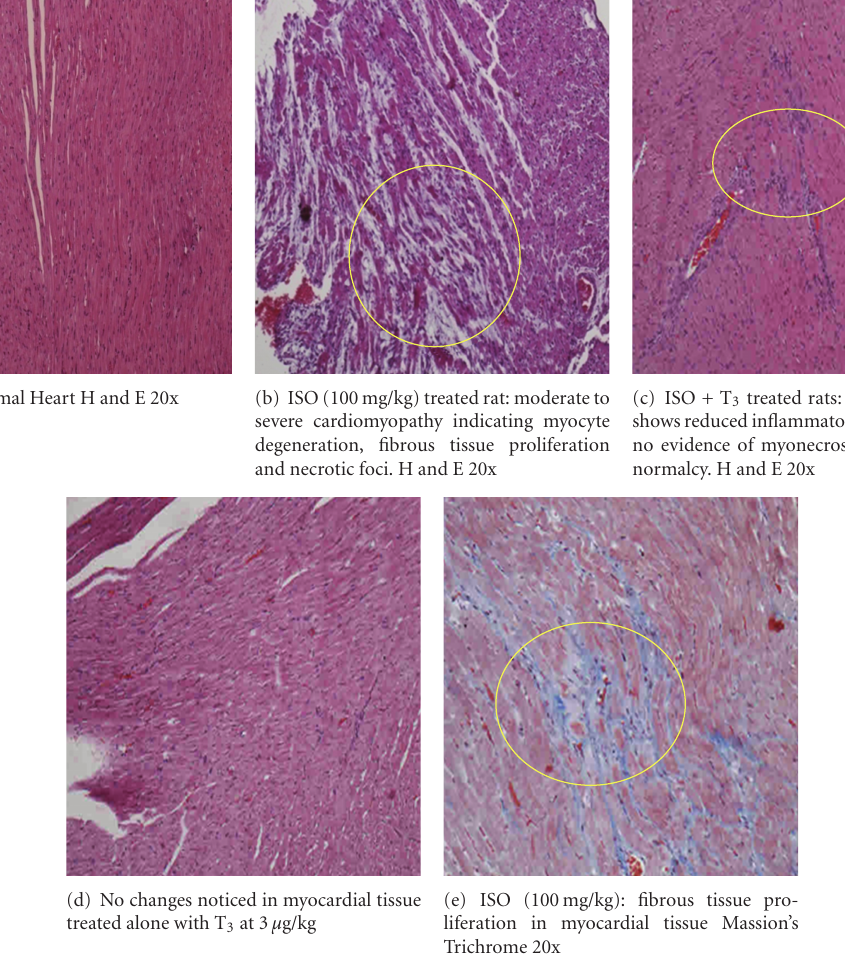
Figure 7: Histopathology of cardiac